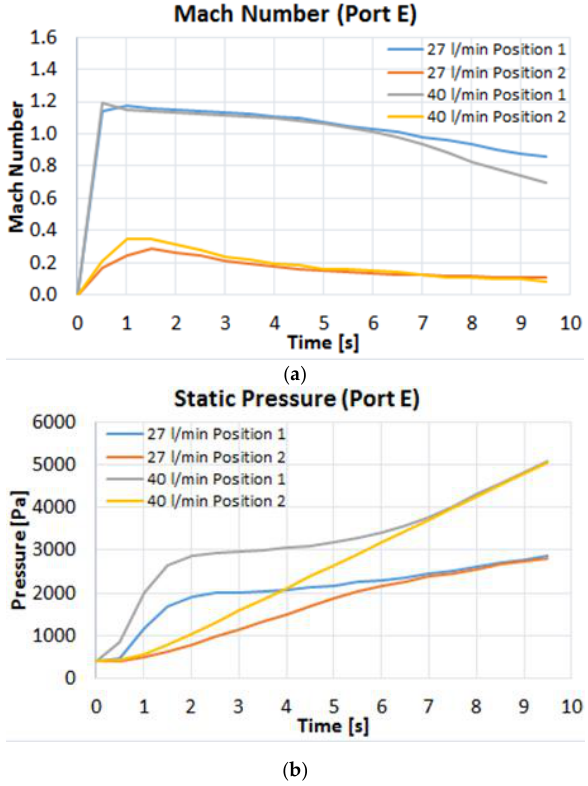
Figure 20. Mach number ( a ) and pressure ( b ) versus time, E port, 27 and 40 L/min